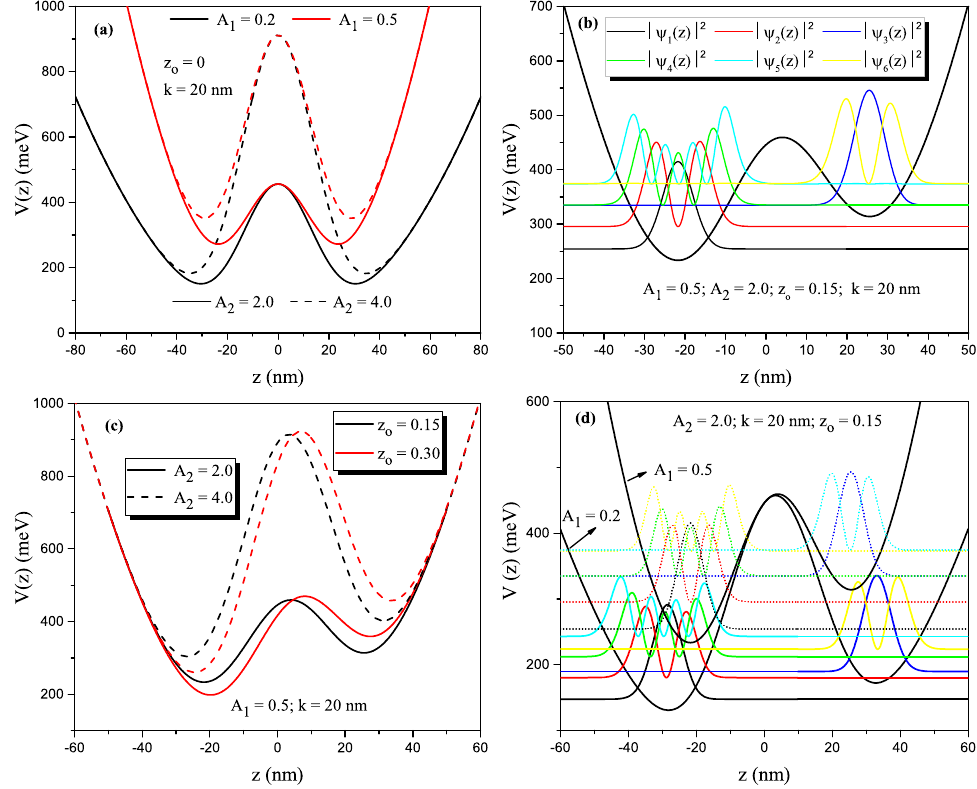
Figure 1. Harmonic-Gaussian DQW confinement potential profile for a constant value of k = 20nm versus the z -growth direction coordinate. Harmonic-Gaussian symmetric DQW, solid (dashed) lines are for A 2 = 2.0 ( A 2 = 4.0) and black (red) lines A 1 = 0.2 ( A 1 = 0.5) ( a ). For z 0 = 0.15, A 1 = 0.5, and A 2 = 2.0 harmonic-Gaussian asymmetric DQW confinement profile and squared wave functions corresponding to the first six energy levels ( b ). For different z 0 -values and some values of the structure parameters, the harmonic-Gaussian asymmetric DQW profile ( c ), and harmonic-Gaussian asymmetric DQW confinement profile and squared wave-functions corresponding to the first six energy levels for the constant values of A 2 and z 0 but two different values of the parameter- A 1 ( d ). For k = 20 nm and z 0 = 0, the variation of the energies corresponding to the first six lower-lying levels of a confined electron within H-G SDQW as a function of the A 2 - parameter for A 1 = 0.2 and A 1 = 0.5 are given in Figures 2a and 2b, respectively. Solid (dashed) lines are for B = 0 ( B = 15 T). As A 2 increases, the barrier height increases